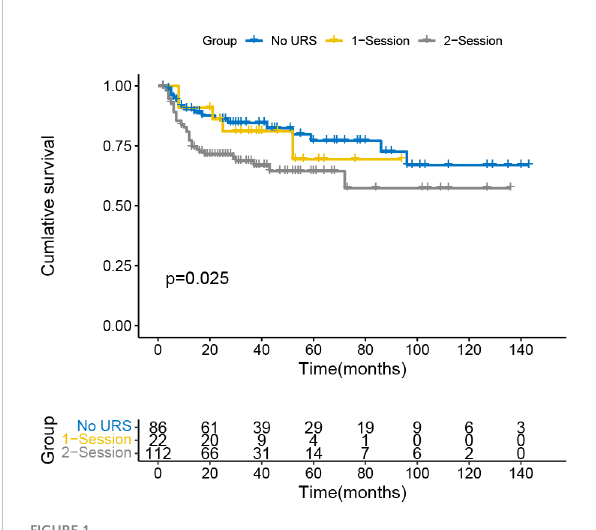
FIGURE 3 Survival analysis of overall survival in all patients.